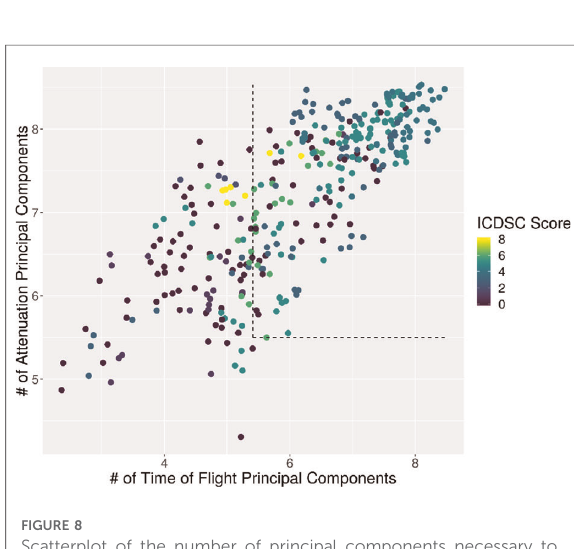
FIGURE 8 Scatterplot of the number of principal components necessary to explain 90% of the variance (dimensionality) calculated for 10 frequencies of attenuation. Each point represents a measurement of a patient at a given time; the points are colored according to their respective ICDSC To determine the predictive power of the features gained, we divided the data into two subsets: patients with an ICDSC or SOFA score of 3 or more were labeled as positive; all other patients were labeled as negative. By using a support vector machine and fi vefold cross-validation, an average accuracy of